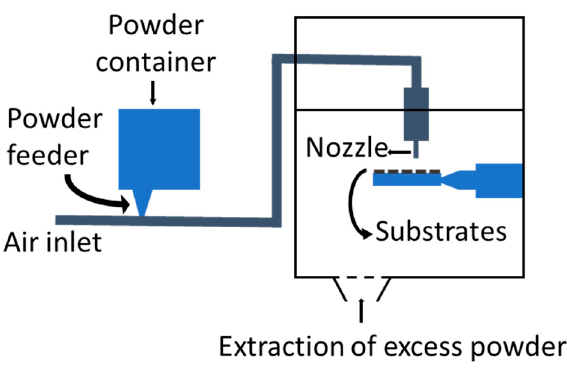
Figure 1. CB experimental setup. Inspired by [33].